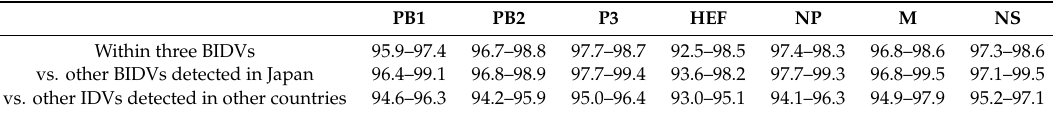
Table 2. Nucleotide sequence identities for seven RNA segments within three bovine influenza D viruses (BIDVs) isolated in this study and among the three BIDVs and other IDVs detected in Japan and other